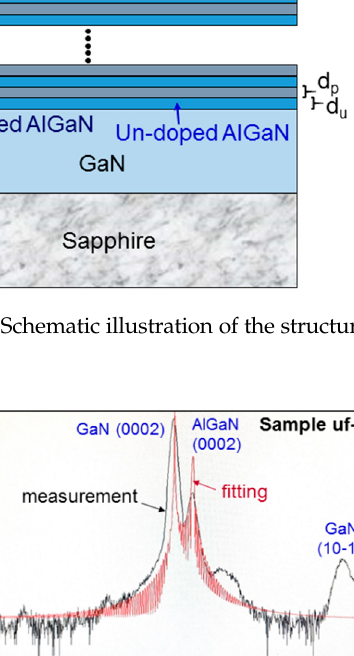
Figure 2. The results of ω -2 θ scan in X-ray diffraction (XRD) measurement for sample uf-u. The black (red) curve shows the measurement data (fitting curve).